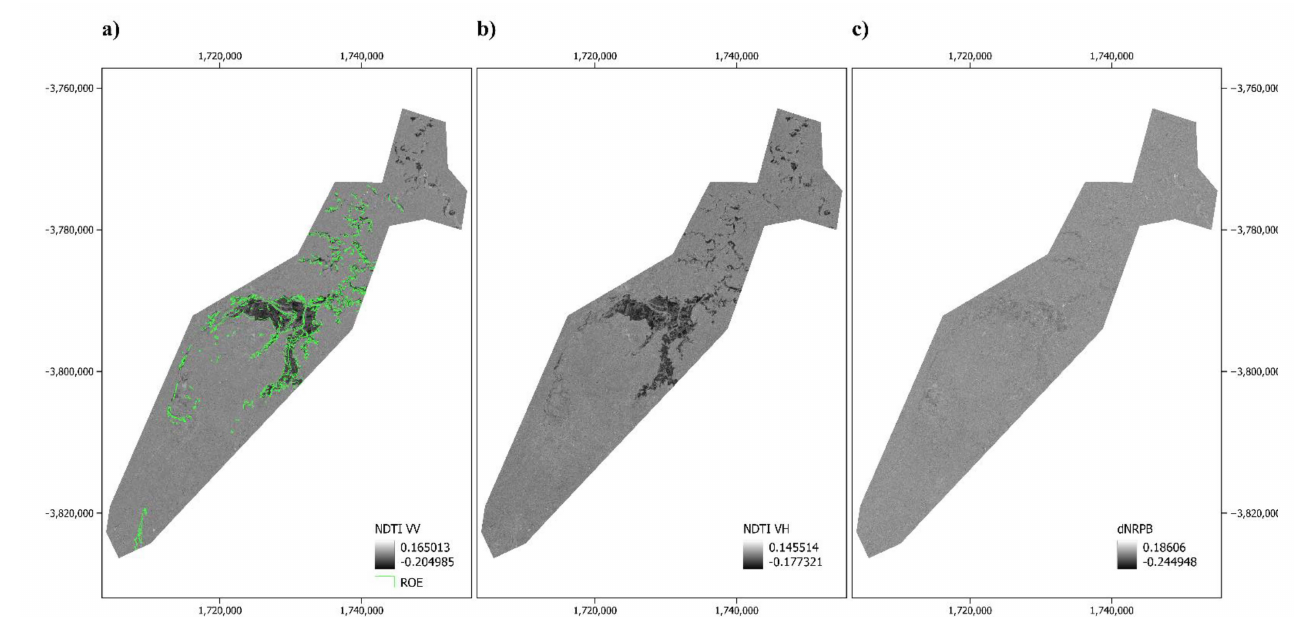
Figure 5. Comparison of SAR-derived index differences (NDTI—Normalized Differenced Temporal Index for both ( a ) vertical-vertical (VV) and ( b ) vertical-horizontal (VH) polarizations; ( c ) dNRPB— difference of Normalized Ratio Procedure between Bands) alongside the delineation of the Refer- ence Observed Event (ROE) [42] for the Richmond floods (Australia) (coordinate reference system: WGS84/World